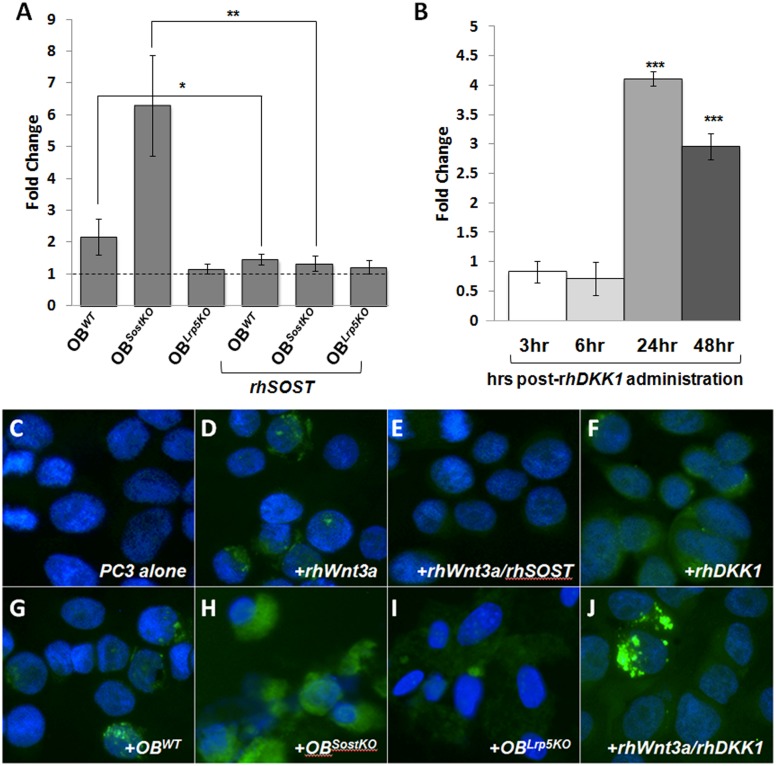
Downstream Wnt activity following 48hrs of co-culture.A, TopFlash reporter Luciferase assay in PC3 cells co-cultured with OBs. B, TopFlash reporter assay in PC3 cells co-cultured with DKK1. C-J, activated β-catenin (ABC) immunohistochemistry in PC3 cells under multiple conditions; green (ABC), blue (DAPI). Results are expressed as fold change ± SEM. * P<0.5, ** P<0.1, *** P<0.01.